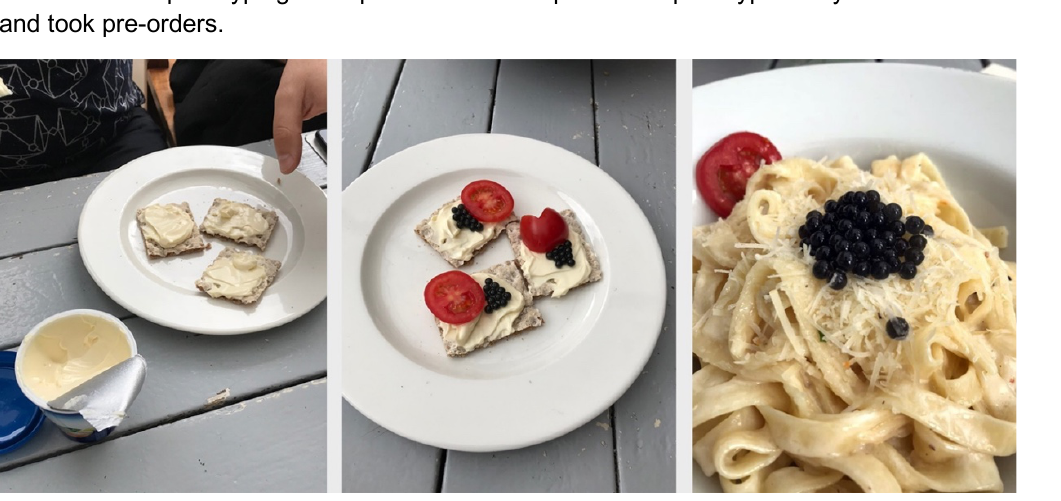
Figure 6: Prototyping during restaurant visits with existing meals Vegan Restaurant and Market visits: He made semi-structured interviews with owners of the vegan restaurants and markets. He also used card sorting method to learn the customer’s perceptions and notions which were needed to be highlighted (Figure